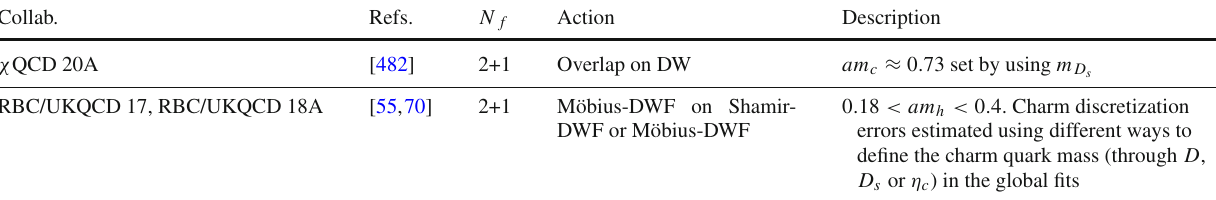
Table 133 Heavy-quark treatment in N f = 2 + 1 determinations of the D - and D s -meson decay constants Collab.